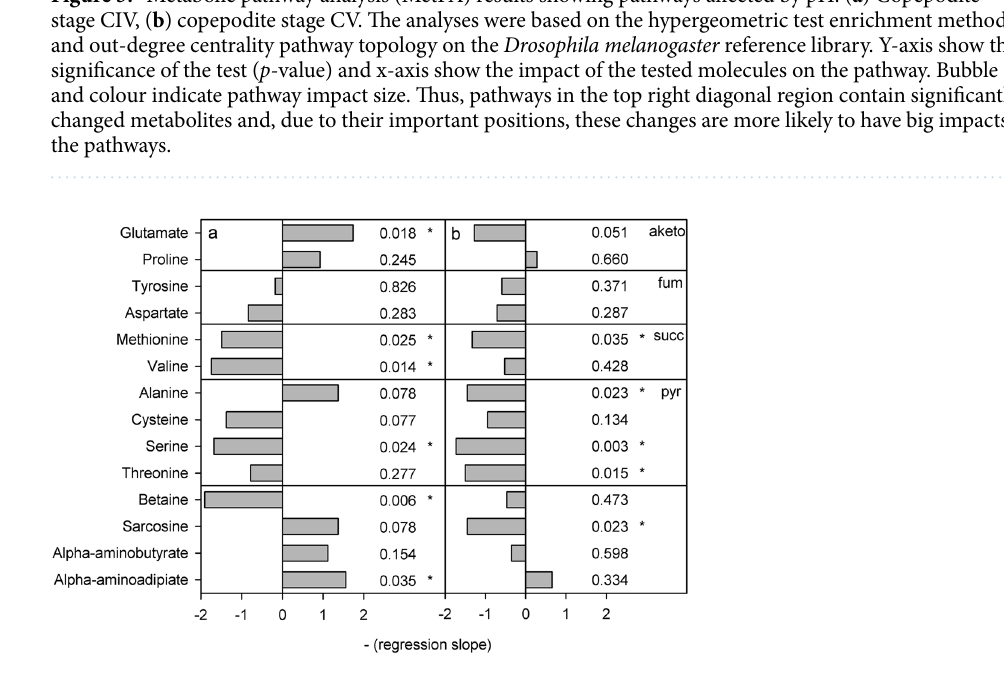
Figure 4. Results of linear regressions on transformed amino acid concentrations in C. glacialis copepodites as a function of pH (range 8.0-7.0 pHT). a) Copepodite stage CIV, b) copepodite stage CV. The horizontal grey bars show negative regression slopes to indicate the direction of change with decreasing pH and the numbers show the p-values of the slopes, asterisks mark significant slopes. Upper four panels show amino acids according to their entry point into the energy metabolism: from the top the four TCA cycle metabolites alpha-ketoglutarate, fumarate/oxaloacetate, and succinate followed by pyruvate in the glycolysis. The bottom four amino acids are not directly metabolised in the TCA cycle or the